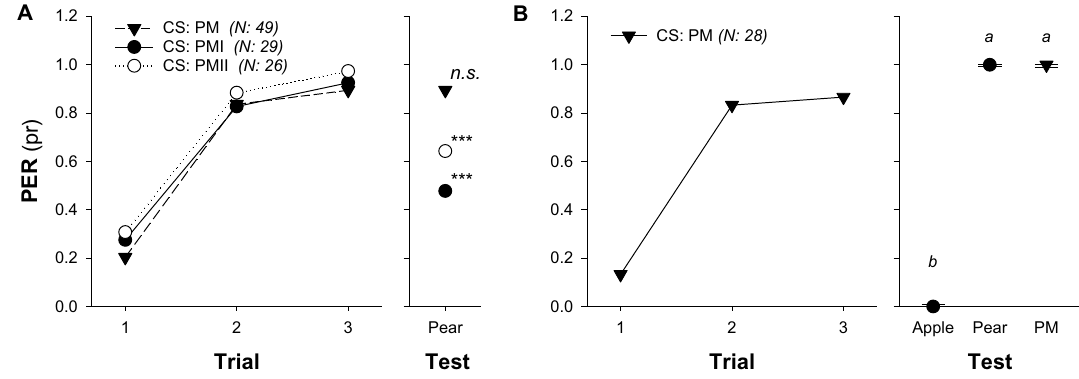
Figure 1. Generalization of memories from pear mimic odours to natural floral scents. ( A ) Generalization was tested towards the single presentation of the pear natural odour (right panel) after one of the pear mimics (PM, PMI or PMII) was used as conditioned stimulus (CS) during an absolute classical conditioning of the proboscis extension reflex (PER; left panel). Asterisks indicate significant differences between responses obtained at the third conditioning trial and the test (***, p < 0.001). No significant difference (n.s.) indicates that bees could not discriminate between PM (3rd trial) and the unrewarded pear natural scent (PER-test). ( B ) Generalization was evaluated towards the single presentation of the natural apple and pear odour (right panel) after PM (from A ) was used as CS during the absolute PER conditioning (left panel). Same letter indicates no significant differences between the generalized response of pear natural odour and the response retrieved by the PM itself. The experimental subjects were all foraging bees completely naïve for the CS that had no access to any pear tree. Symbols indicate the proportion of PER and bars (in test) show the 95% confidence intervals. Numbers between brackets indicate sample size. Package ‘lme4’, version 1.1-30. https:// github. com/ lme4/